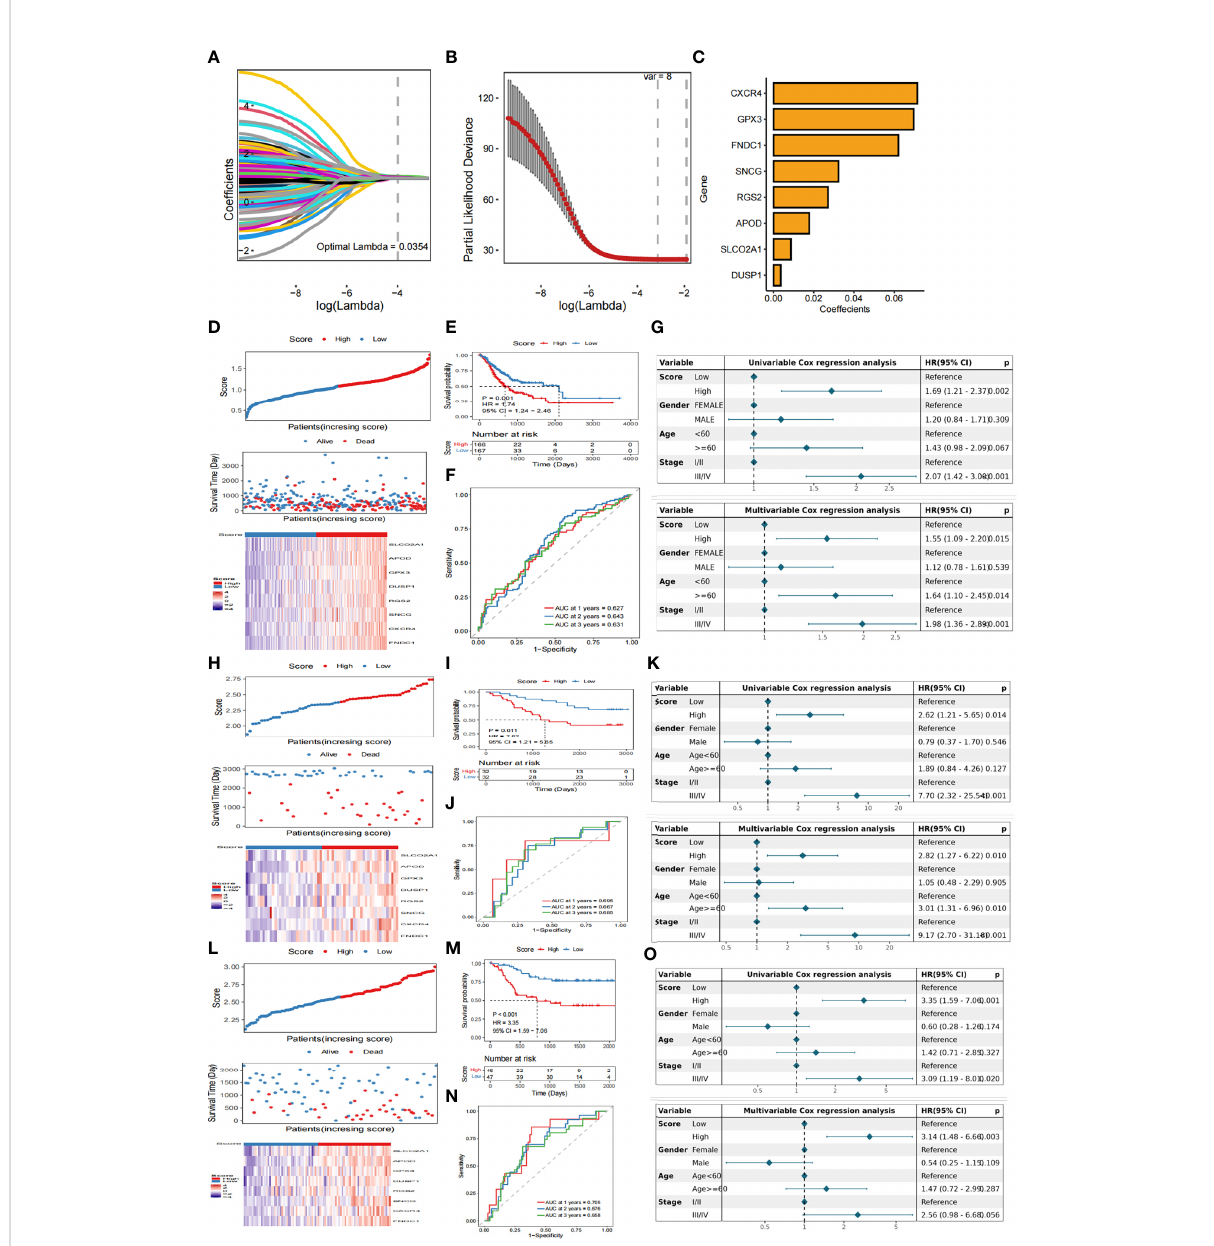
FIGURE 3 Construction of hierarchical scoring system for Fatty Acid related prognosis (A) LASSO coef fi cient pro fi les of eight genes. (B) Tuning parameter lambda ( l ) selected by cross-validation error curve. (C) Eight genes determined based on the optimal value of l (D) The relationship between survival status/risk score of TCGA cohort, mRNA expression heat map of 8 genes and survival time (days)/risk score. (E) Kaplan-Meier OS analysis of gastric cancer patients in low-risk and high-risk groups (F) The time-dependent ROC curve of TCGA training data set OS. AUC was evaluated at 1 year, 3 years and 5 years, respectively. p value was calculated using the log-rank test. p< 0.001. (G) Univariate and multivariate Cox analysis were used to determine whether Score was an independent prognostic factor for OS. (H) GSE13861 dataset was used to analyze the relationship between survival status/risk score, mRNA expression heat map of 8 genes and survival time (days)/risk score. (I) Kaplan-Meier OS analysis of gastric cancer patients in low-risk and high-risk groups based on GSE13861 data set (J) Time-dependent ROC curve of GSE13861 dataset OS. AUC was evaluated at 1 year, 3 years and 5 years, respectively. P value was calculated using the log-rank test. P< 0.001. (K) The GSE13861 dataset uses univariate and multivariate Cox analysis to determine whether Score is an independent prognostic factor for OS. (L) The relationship between survival status/risk score, mRNA expression heat map of 8 genes and survival time (days)/risk score was analyzed by GSE26899 dataset. (M) Kaplan-Meier OS analysis of gastric cancer patients in low-risk and high-risk groups based on GSE26899 data set (N) Time-dependent ROC curve of GSE26899 dataset OS. AUC was evaluated at 1 year, 3 years and 5 years, respectively. P value was calculated using the log-rank test. P< 0.001. (O) The GSE26899 dataset uses univariate and multivariate Cox analysis to determine whether Score is an independent prognostic factor for